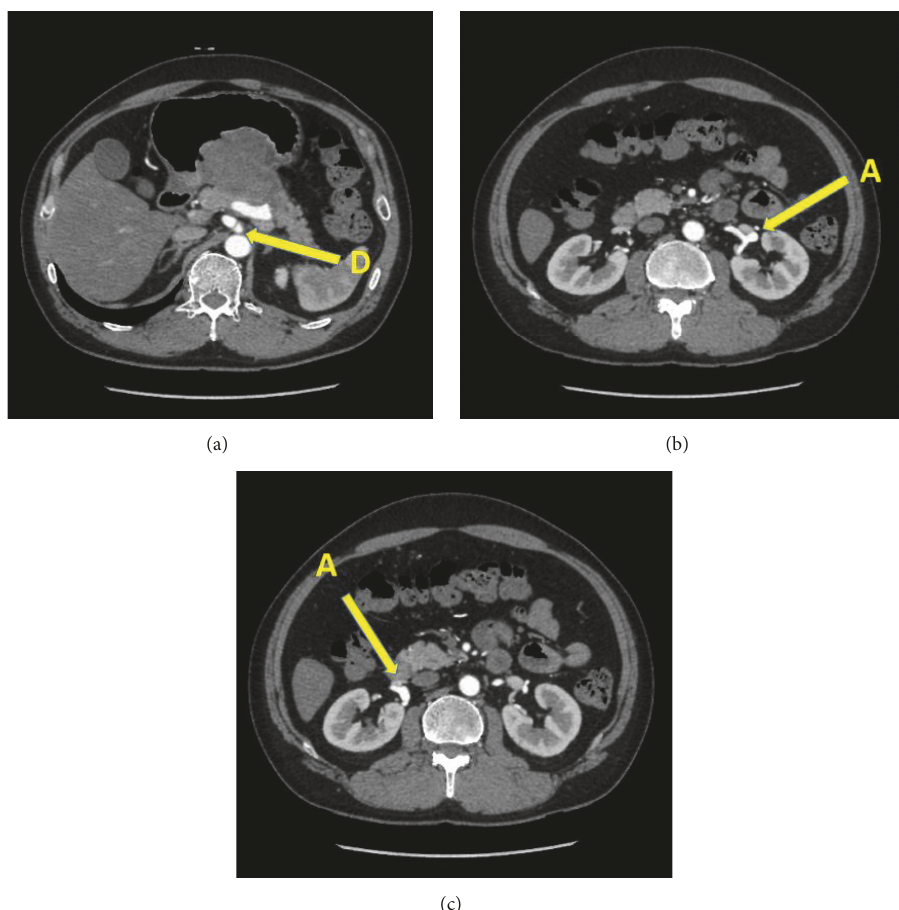
Figure 4: CT angiogram indicated dissection of common hepatic artery as well as aneurysms of the common hepatic artery (maximum diameter, 8 mm) and bilateral renal artery (maximum diameter, 5mm). D: dissection; A: aneurysm.